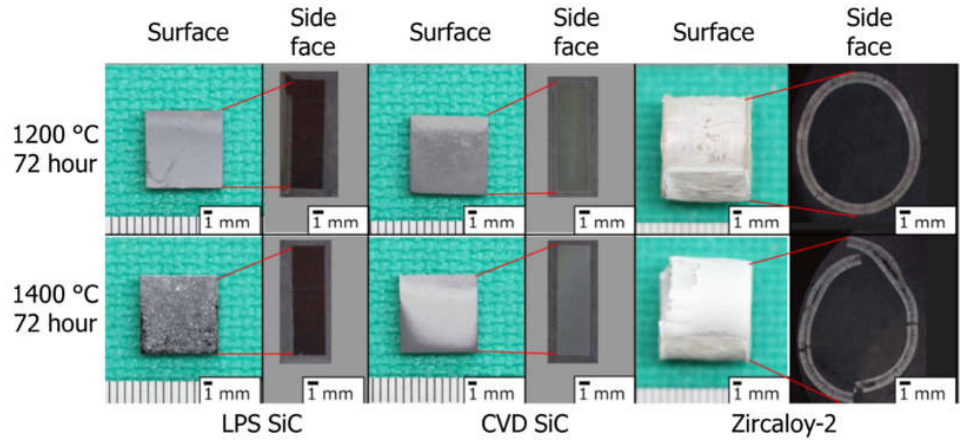
Figure 1. High-temperature steam oxidation behavior of the LPS SiC, the CVD SiC, and the Zircaloy-2 following steam oxidation for 72 h at 1200 and 1400 °C.